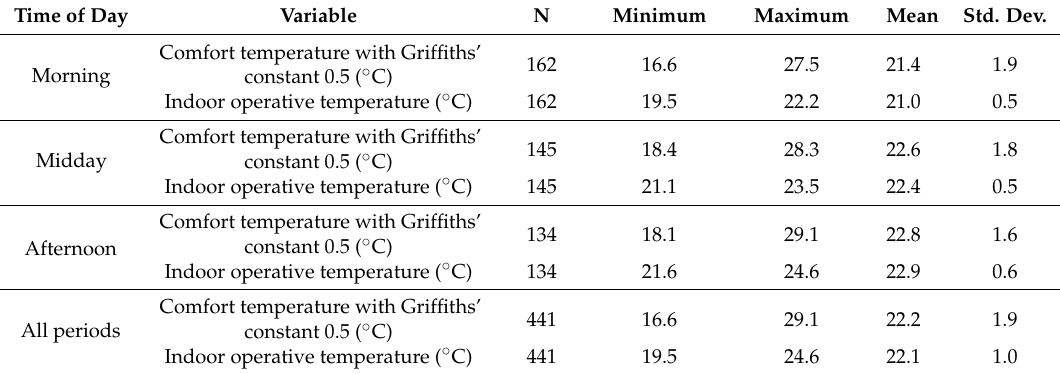
Table 6. Indoor operative temperature and comfort temperatures calculated using the Griffiths’ method.